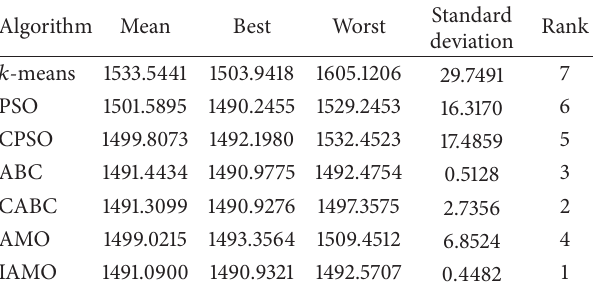
Table 4: Results obtained by the algorithms for 20 different runs on TAE data.